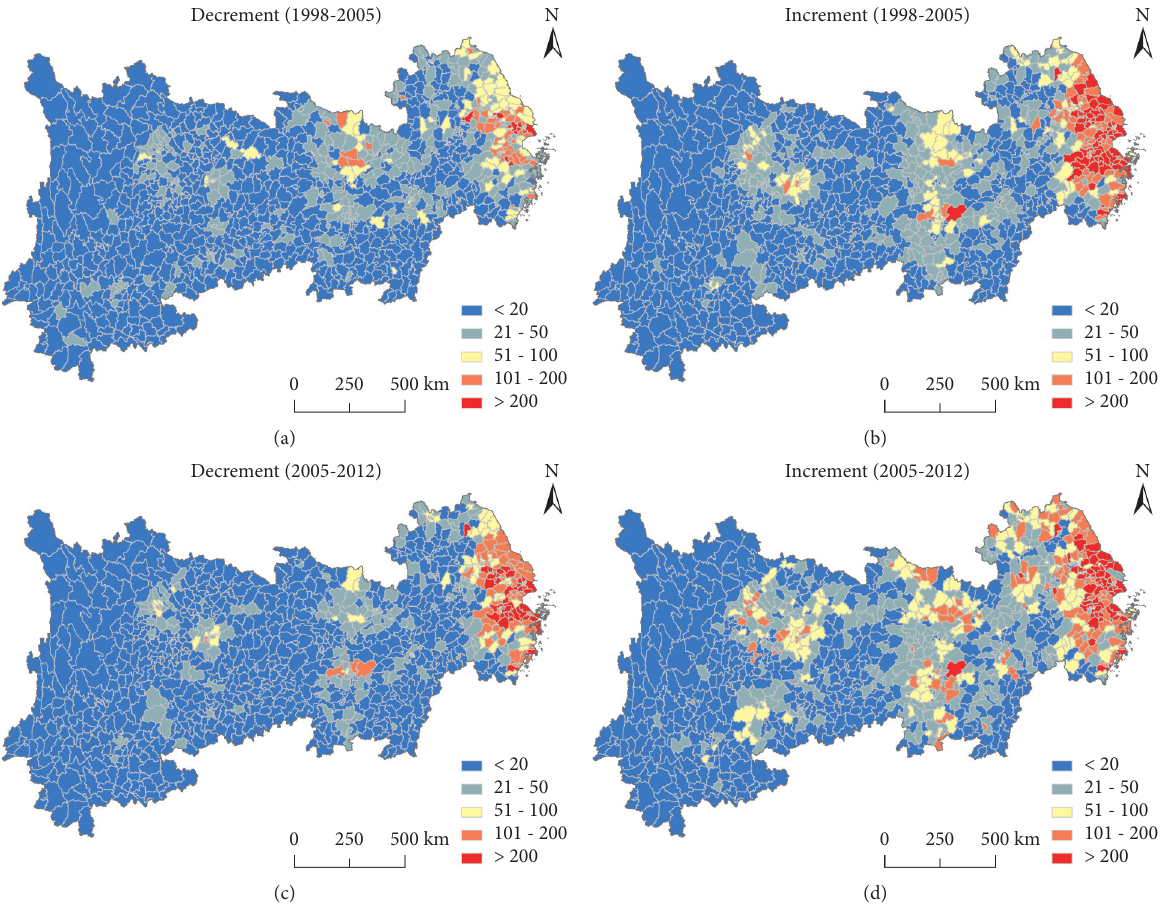
Figure 7: Changes in the number of water pollution-intensive enterprises. (a) Decrement (1998–2005). (b) Increment (1998–2005). (c) Decrement (2005–2012). (d) Increment